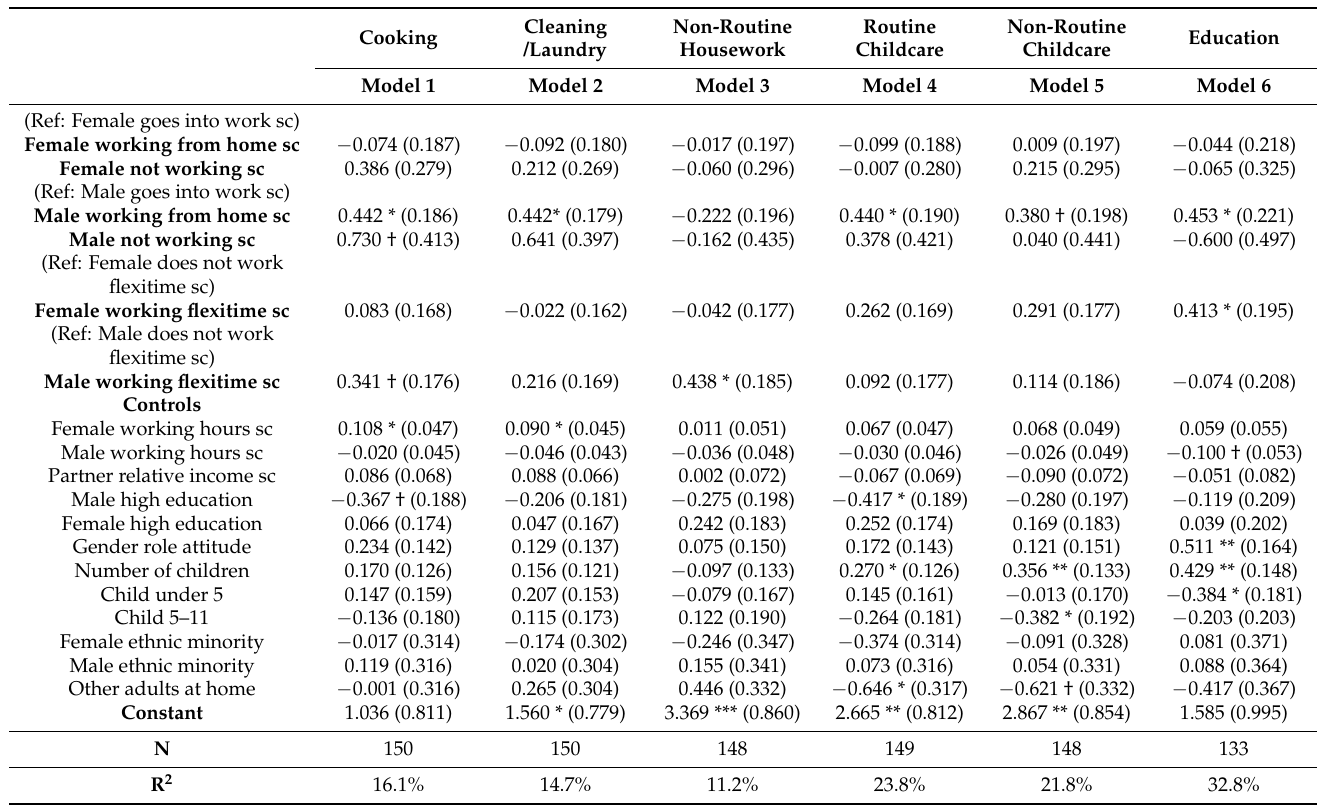
Table A2. Model explaining the changes in the amount of housework and childcare men carried out during the COVID-19 lockdown compared to before the lockdown for heterosexual dual earning couples with children under 18 (male respondents’ perception of their own time)—continuous.